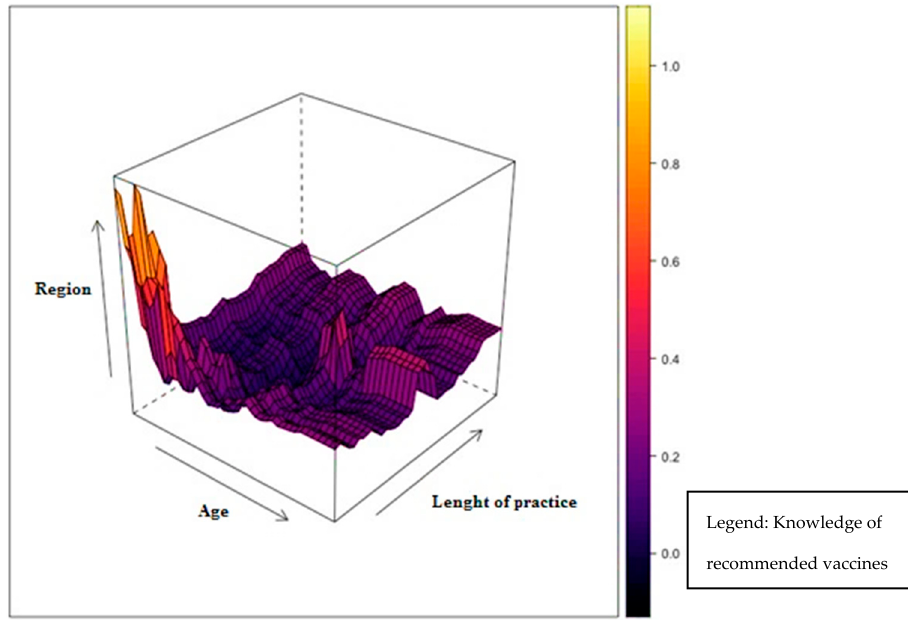
Figure 3. Model simulations according to Age, Length of practice, and Region variables versus knowledge of the recommended vaccinations.